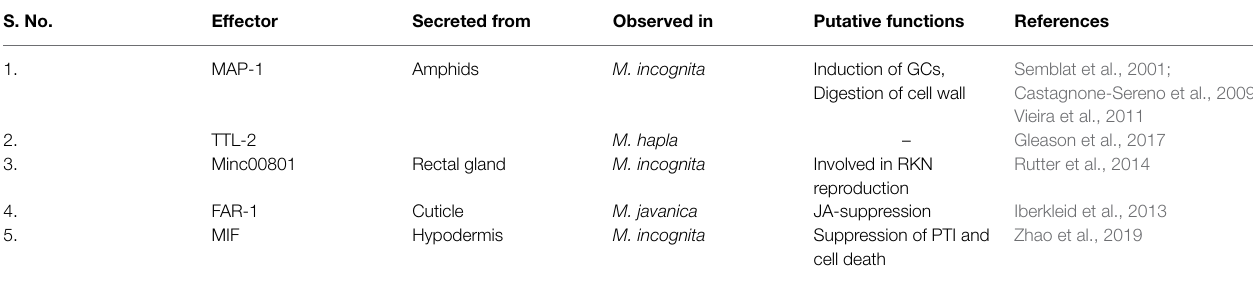
TABLE 3 | Experimentally identified non-oesophageal effectors from various RKNs. S.